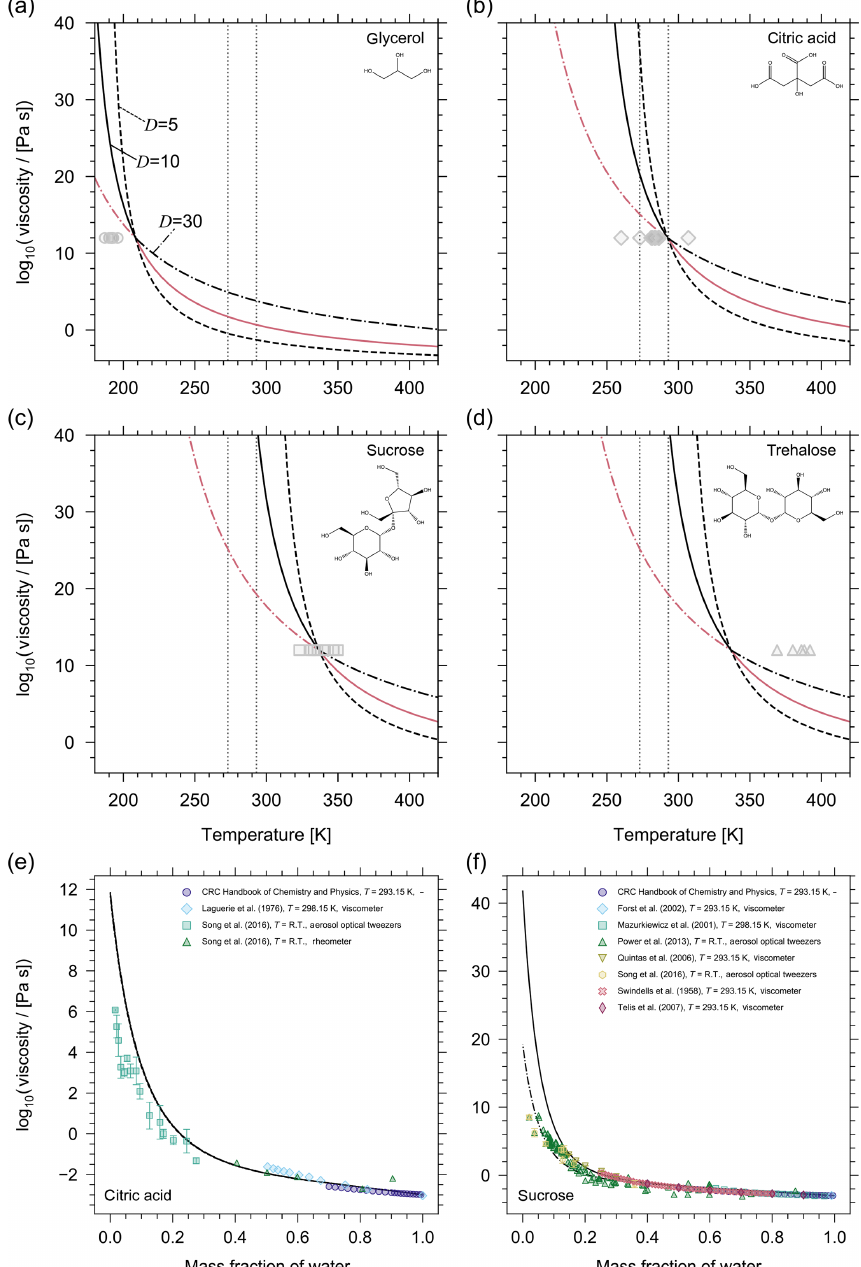
Figure 2. Prediction of the pure-component viscosity ( η 0 ) as a function of temperature using the method by DeRieux et al. (2018) for (a) glycerol, (b) citric acid, (c) sucrose, and (d) trehalose. The three curves in each panel show the effect of different fragility parameters on the pure-component viscosity prediction (solid, D = 10; dashed, D = 5; dash-dotted, D = 30). The pink lines illustrate which fragility parameter the model uses as a function of temperature; i.e. when T > T g then D = 10 and when T < T g then D = 30. The grey symbols are reference values of T g (either measured or parameterized) where horizontal error bars have been omitted for clarity (additional information and the sources of the T g values can be found in Table S1). The reference values of T g have been plotted using the convention that η 0 (T g ) = 10 12 Pas. The vertical grey dotted lines denote 0 ◦ C and 22 ◦ C. (e, f) Mixture viscosity predictions from AIOMFAC-VISC for (e) citric acid and (f) sucrose are shown for different fragility parameters where the curve line styles follow the same convention as in (a–d) . For citric acid, the model results with D = 5, D = 10, and D = 30 are nearly identical, so the curves are indistinguishable. For sucrose, D = 10 (solid) and D = 30 (dash-dotted) are shown. For a detailed discussion of the AIOMFAC-VISC results, see Fig. 5 and Sect.